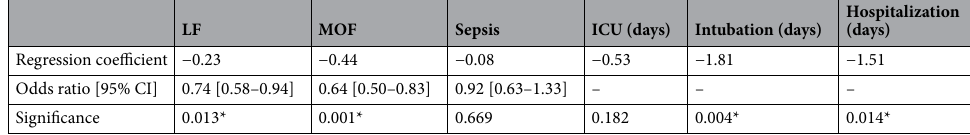
Table 3. Influence of operative treatment on outcome parameters. Regression model includes: age, sex, ISS, AIS